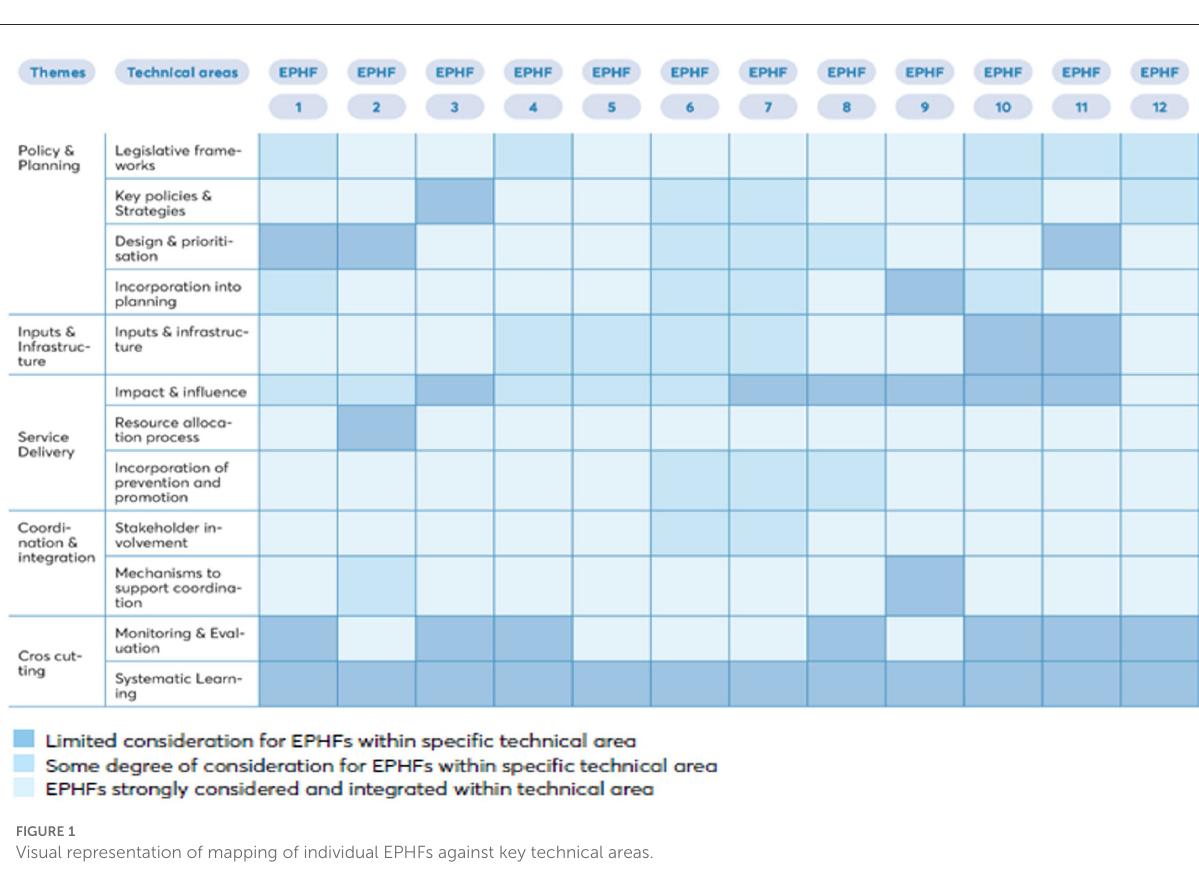
between systems. A dearth of modeling capacity in the HPSC existed prior to the COVID-19